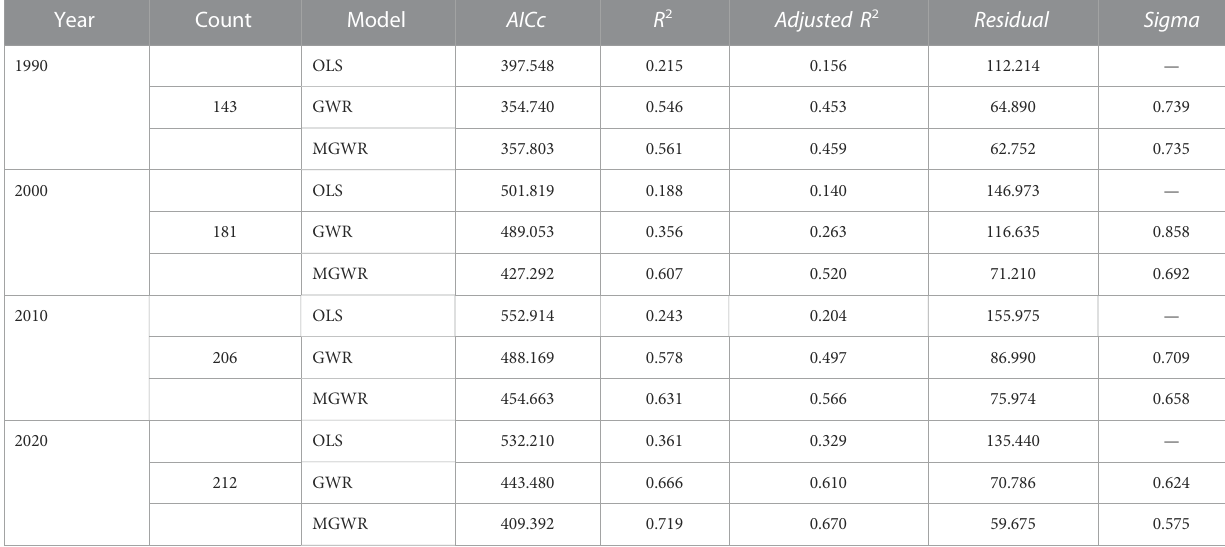
TABLE 3 Comparison of analytical results of OLS, GWR and MGWR models.